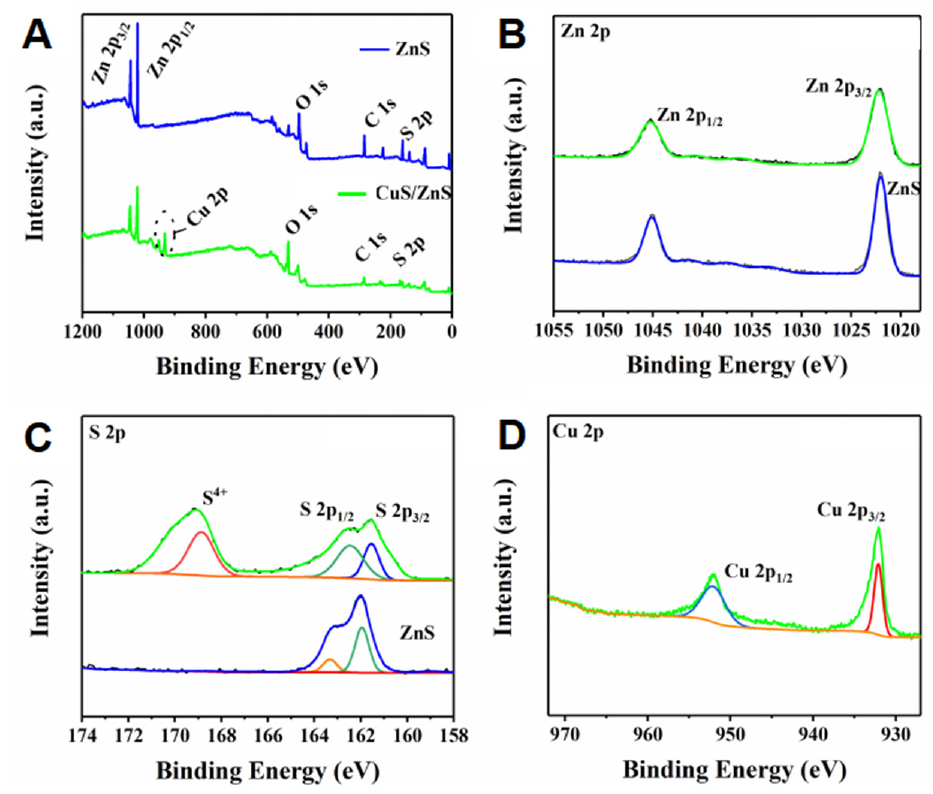
Figure 2. High-resolution XPS spectra of ZnS and CuS/ZnS ( A ), Zn 2p ( B ), S 2p ( C ), and Cu 2p ( D ).